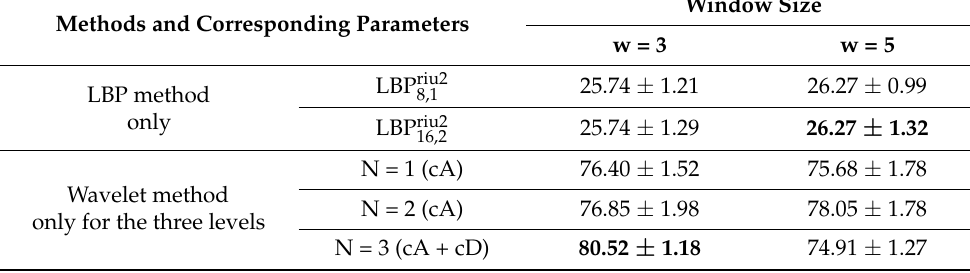
Table 3. Classification accuracy (OA) for the Indian Pines dataset with different windows size, of dimension 3 × 3 and 5 × 5, for the controlled sampling strategy, without filtering, using the window size for the LBP histogram computation, or the wavelet transform on three levels, with low pass coefficients (cA), respectively high pass coefficients (cD).